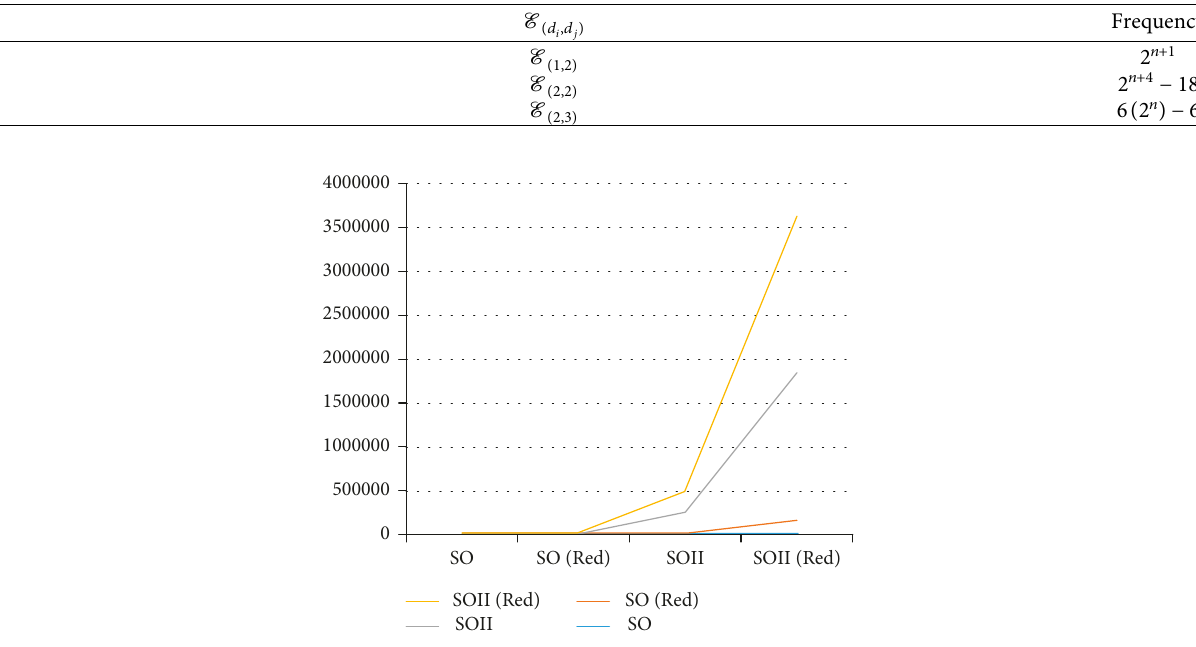
, SOII, and SOII red red